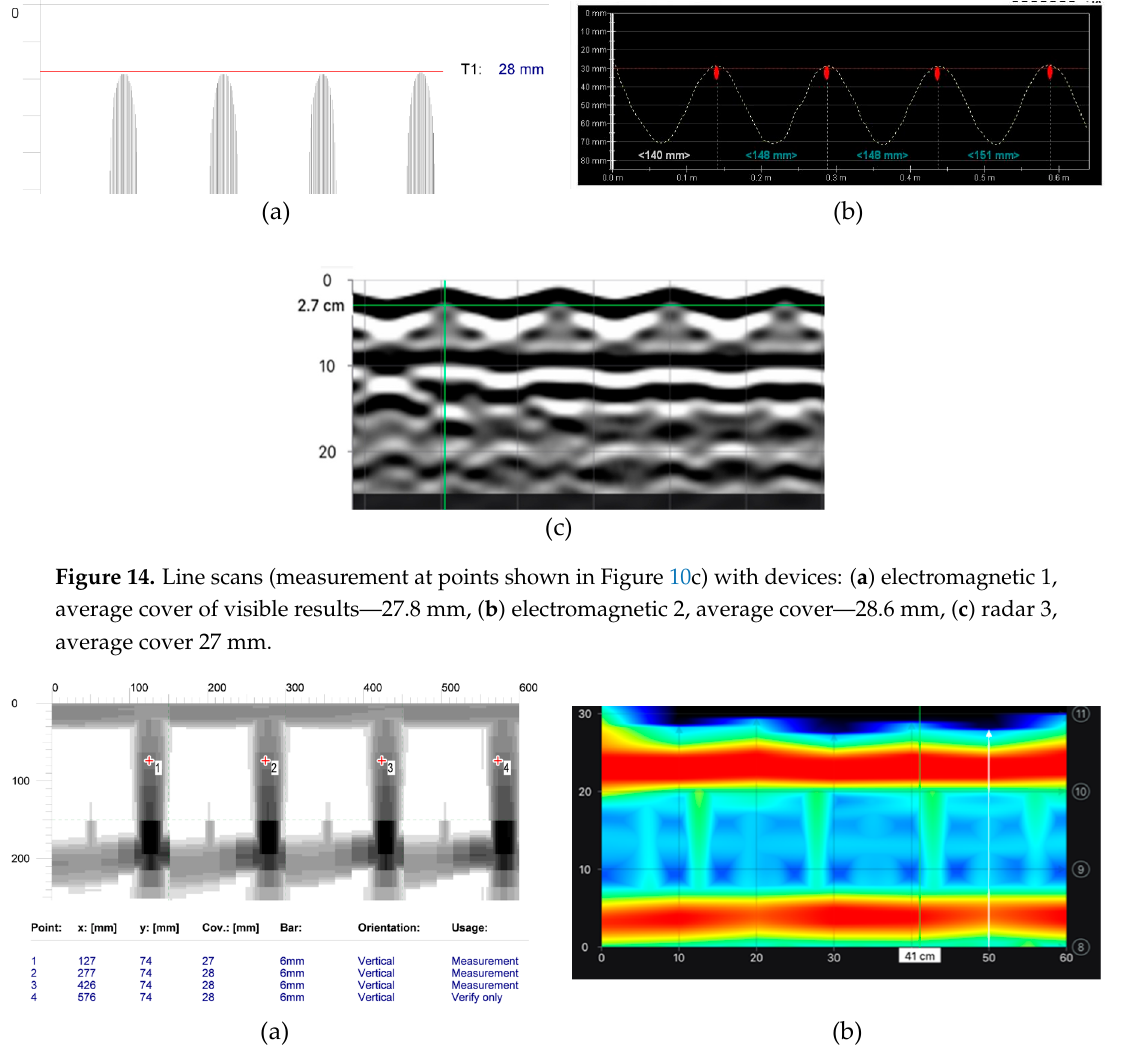
Figure 15. Area scans conducted with electromagnetic devices (measurement on the surface shown in Figure 10a), ( a ) electromagnetic 1, average cover of visible results– 27.8 mm, ( b ) radar 3,– 27